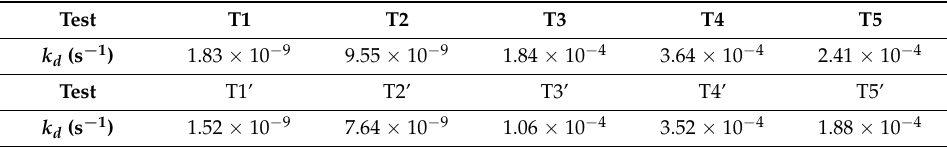
Table 2. Deposition rates used from simulation of colloidal